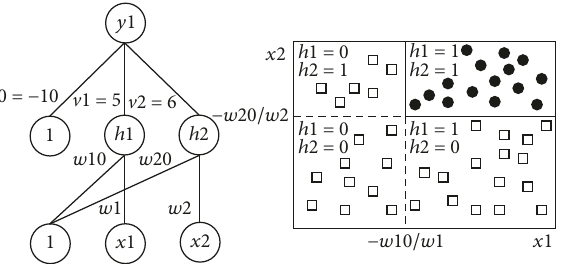
Figure 1: A DIMLP network creating two discriminative hyperplanes. The activation function of neurons ℎ 1 and ℎ 2 is a step function, while for output neuron 𝑦 1 it is a